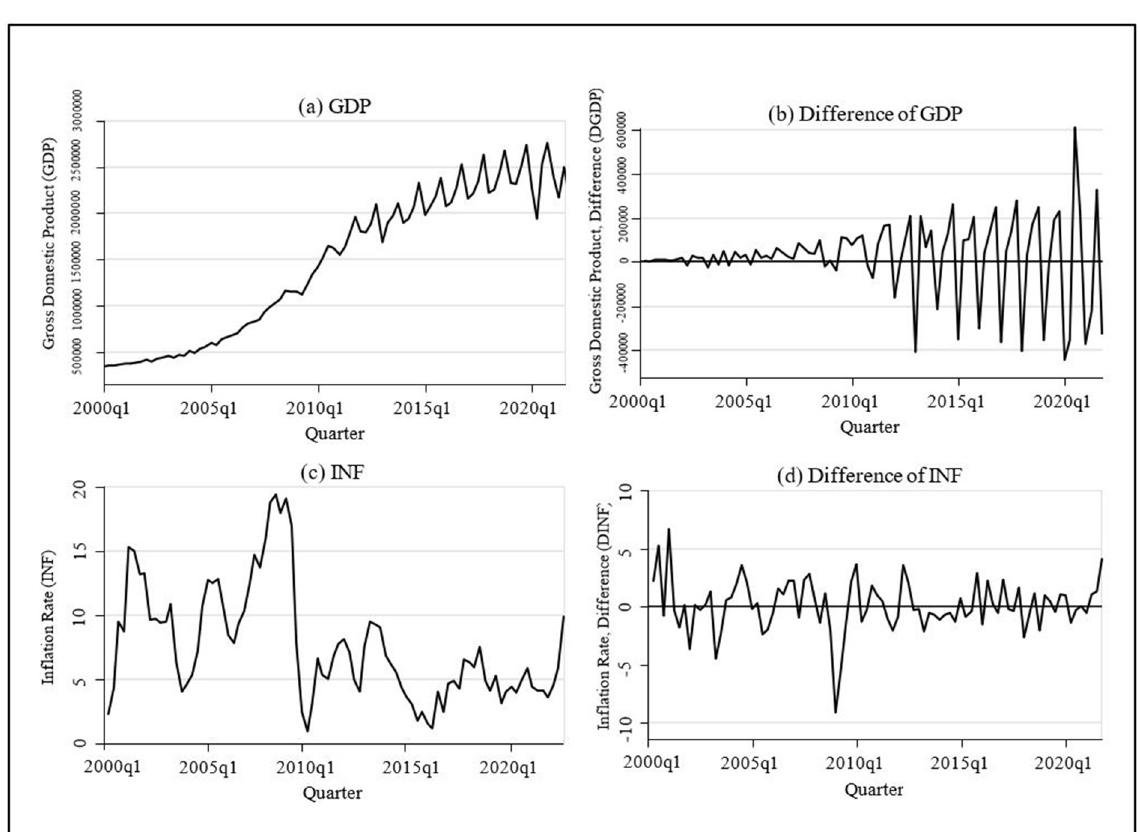
Fig 3. Time series plot to check stationary. Source: Authors’ illustration based on CBSL [56] and DCS [57].